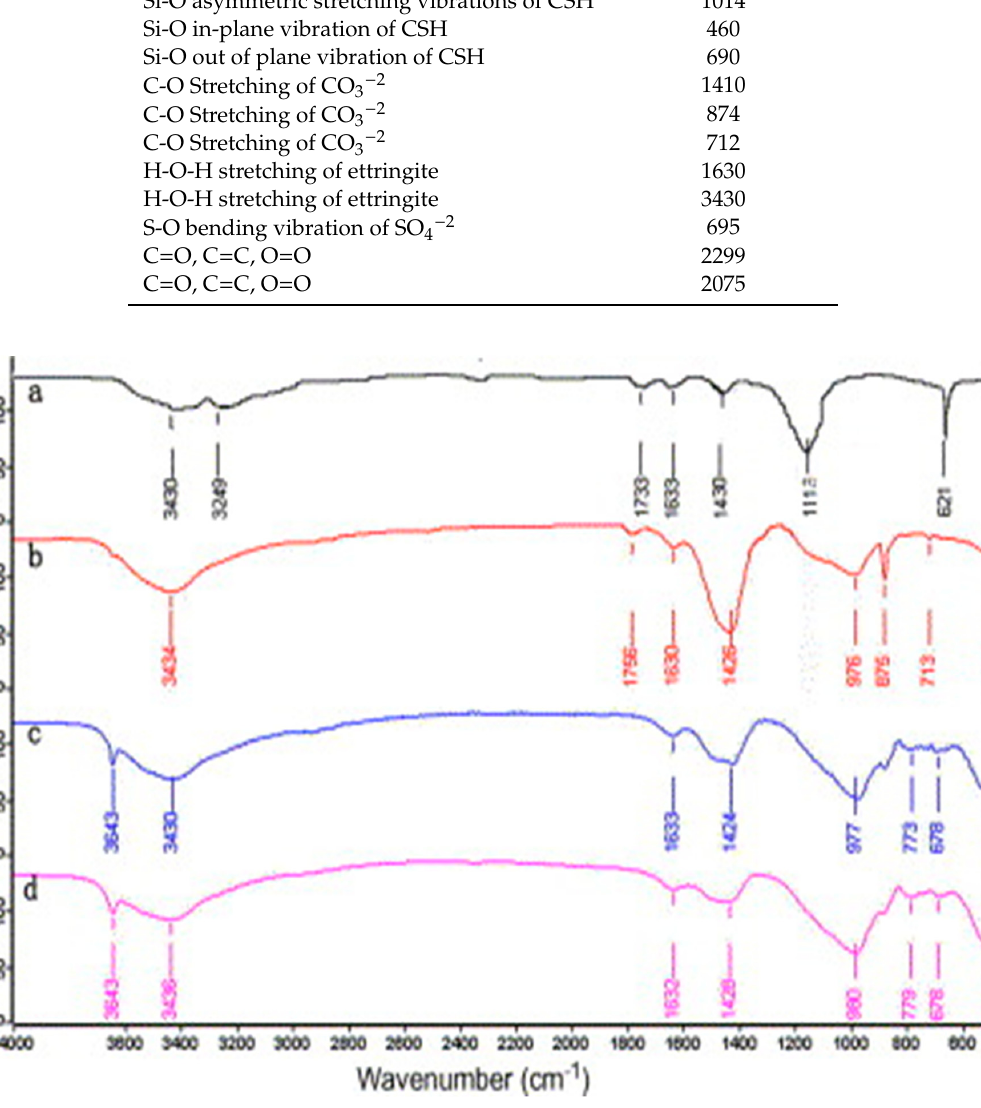
Figure 13. FT-IR spectra of various cement composites at age of 90 days. ( a ) carboxylic carbon nanotubes; ( b ) carboxylic carbon nanotubes cement paste; ( c ) carbon fibres cement paste and; ( d ) plain cement paste. Reproduced with permission from [48], Elsevier, 2005.